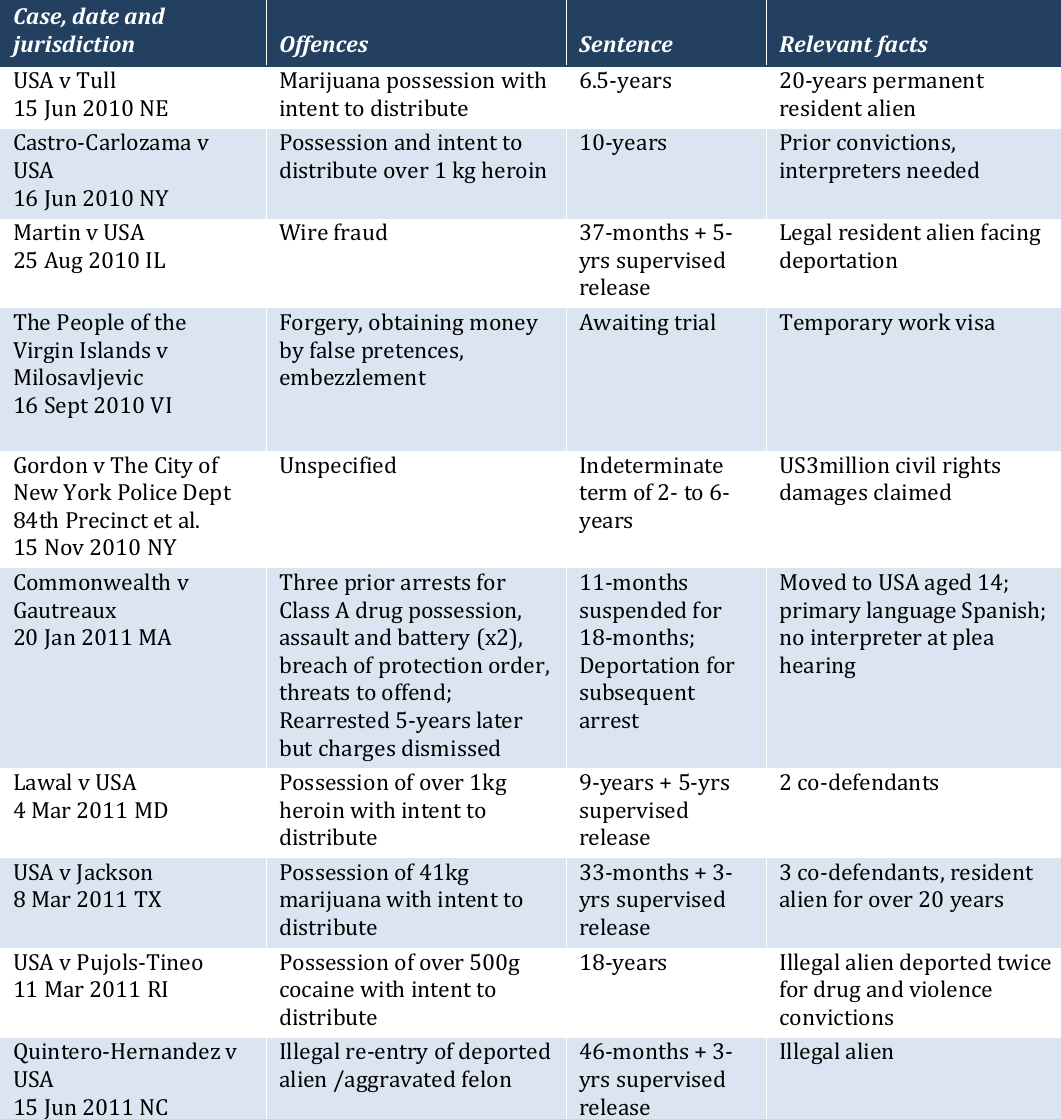
Table 2 documents the charges, sentences and key facts in ten remaining cases in this sample. Table 2: US non ‐ homicide cases raising Article 36, January 2010 ‐ July